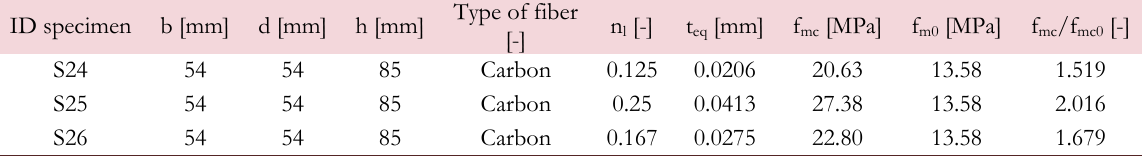
Table 5.B: Geometrical characteristics and experimental results [35].